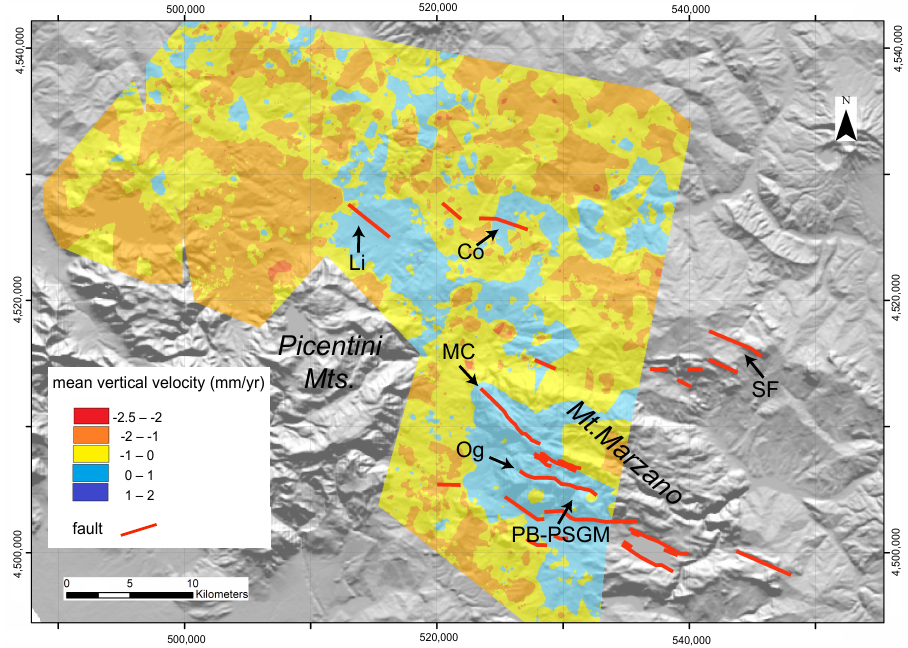
Figure 11. ENVISAT data: Vertical mean velocity deformation map 2003–2010, IDW interpolation (cell 50 × 50 m). Data statistical selection with Cluster and Outlier Analysis , i.e., map constructed using the ENVISAT subsets labelled ‘CO_2k_IDW_nout’ (which includes only PS classified as HH and LL). Fault / fault array labelling as in Figure